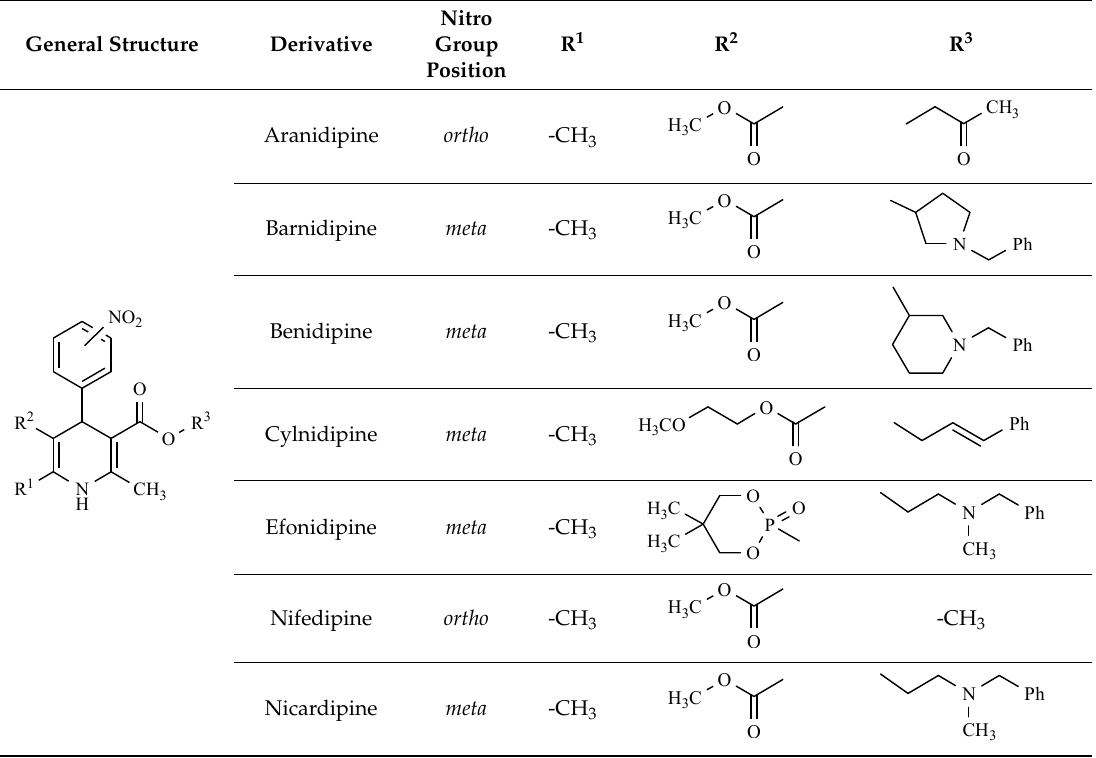
Table 1. Nifedipine derivatives.